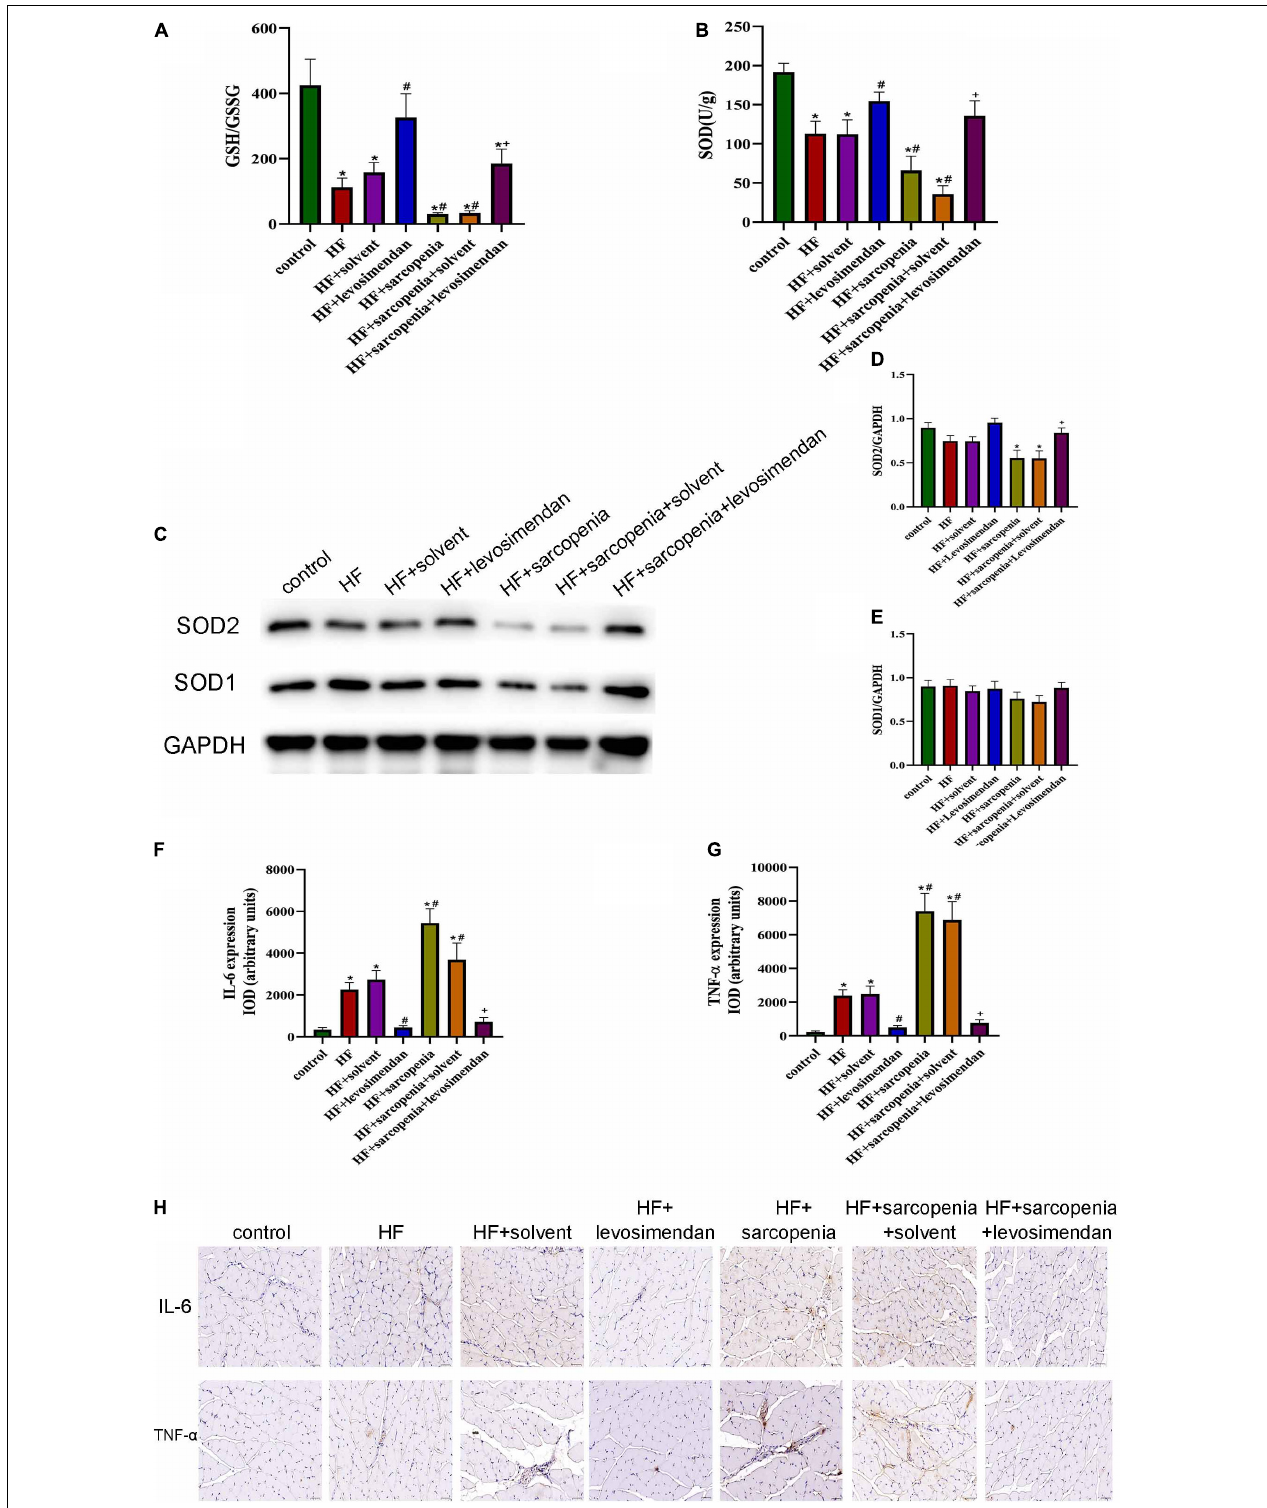
FIGURE 7 | Possible causes of skeletal muscle apoptosis (A) the glutathione redox state (GSH/GSSG) in gastrocnemius. (B) The activity of superoxide dismutase (SOD) in gastrocnemius (U/g). (C–E) Detection of SOD1, SOD2 expression through western blotting; GAPDH: internal reference. (F,G) Relative expression IOD of IL-6 and TNF- α . (H) Immunohistochemical staining of IL-6 and TNF- α . N = 5–12. * P < 0.05 vs. control, # P < 0.05 vs. HF, + P < 0.05 vs. HF + sarcopenia. Bar = 40 µ m.